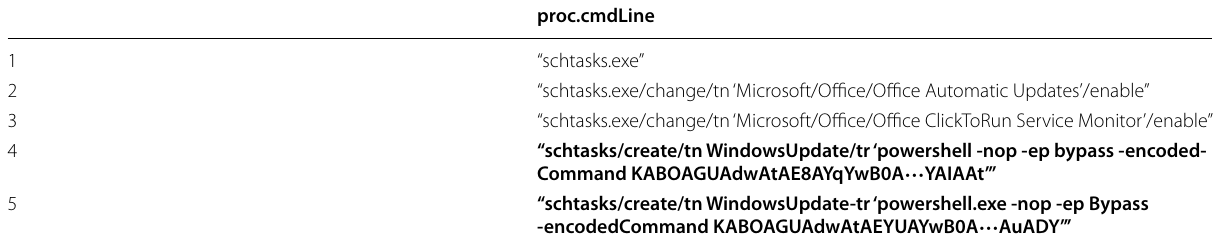
Table 2 Hunting results in